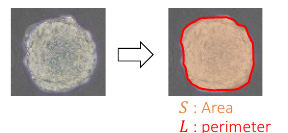
Figure 3. Quantitative analyses for spheroid growth using phase-contrast microscopy images.